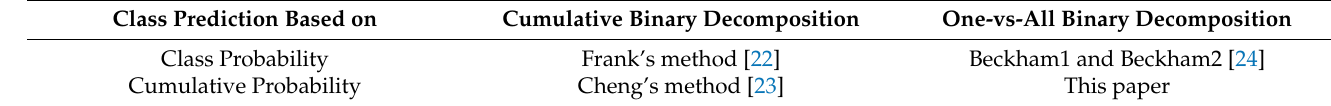
Table 1. Summary of ordinal classification methods. Class Prediction Based on Cumulative Binary Decomposition One-vs-All Binary Decomposition Class Probability Frank’s method [22] Cumulative Probability Cheng’s method [23] This